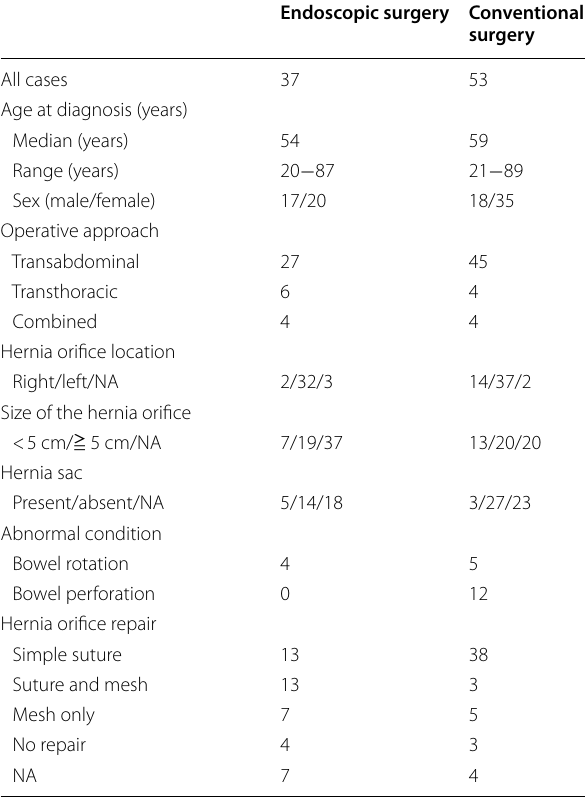
Table 2 Characteristics of Japanese cases with endoscopic and conventional surgery for adult Bochdalek